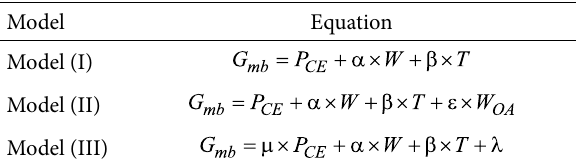
Table 5. 1 st to 3 th multivariate models Model